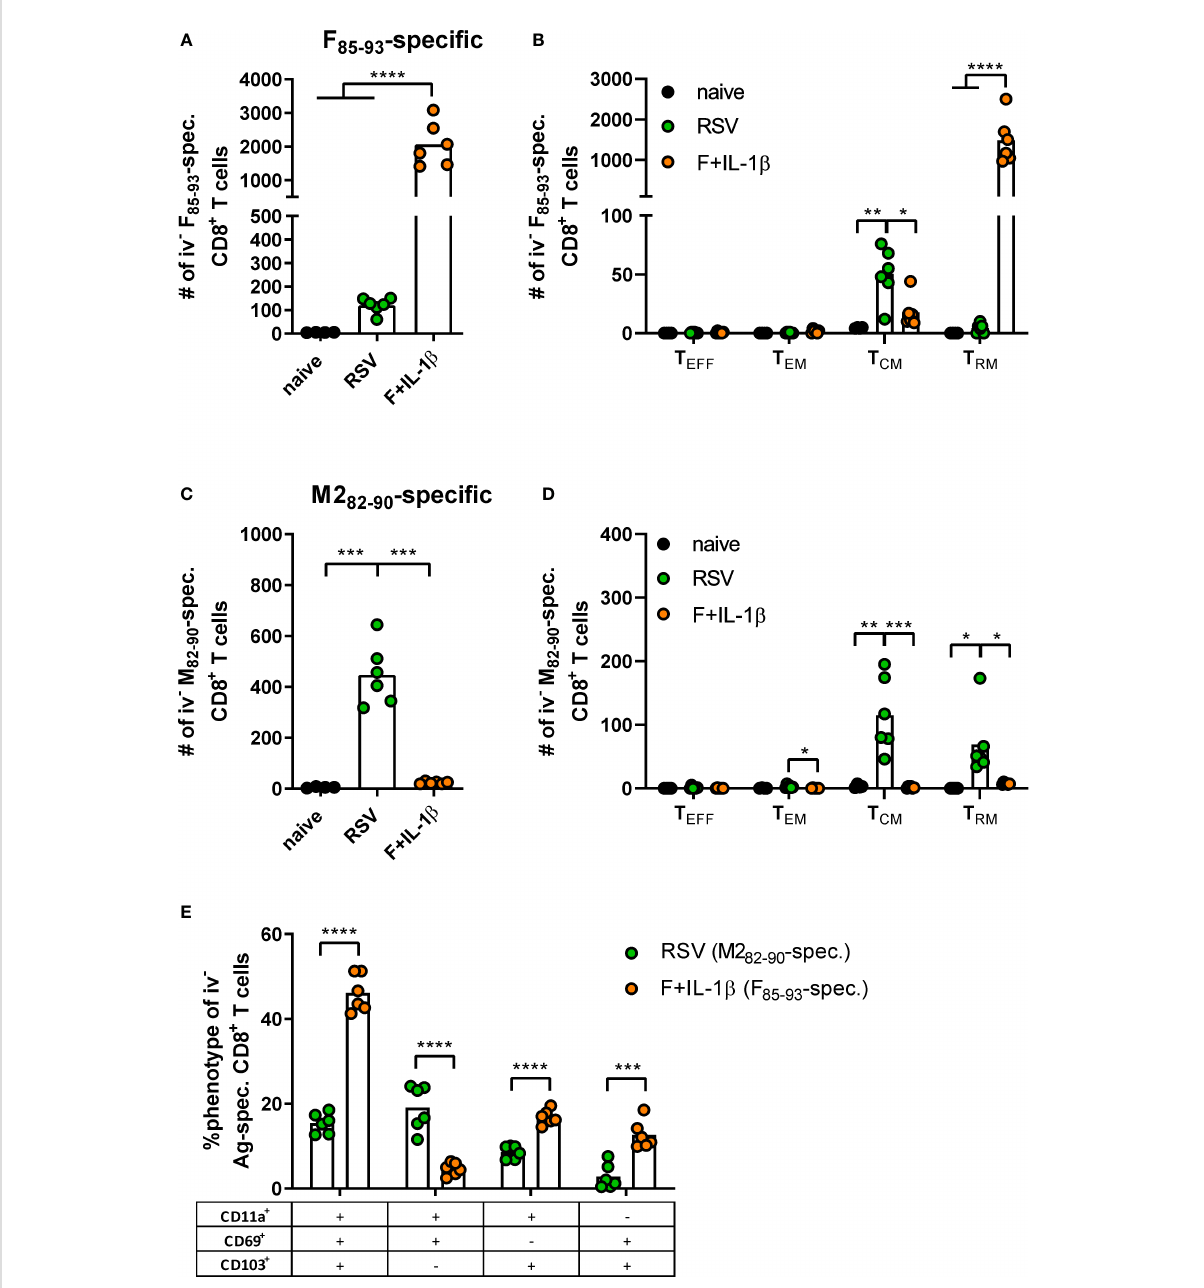
FIGURE 5 T cell phenotypes induced by mucosal vaccination and a primary RSV infection. BALB/cJRj mice were immunized or infected as described above and isolated lung lymphocytes were analyzed seven weeks later. Counts of F 85-93 pentamer + (A) and M2 82-90 pentamer + CD8 + T cells (C) per lung and of speci fi c memory T cell subsets (B, D) are shown; effector T cells, T EFF , KLRG1 + CD127 - ; effector memory T cells, T EM , KLRG1 + CD127 + ; central memory T cells, T CM , KLRG1 - CD69 - CD103 - CD127 + ; T RM , KLRG1 - CD127 +/- CD69 + CD103 + ; gating scheme in Supplementary Figure 2. (E) Pentamer + CD8 + T cells (M2 82-90 -spec. in RSV group, F 85-93 -spec. in Ad-F+Ad-IL-1 b group) that were not stained by the intravenous staining were further characterized for their expression of CD11a, CD69, and CD103. Bars represent group means overlaid with individual data points. n=4-6. Data were analyzed by one-way ANOVA followed by Tukey´s post test (A-D) or two-tailed Student ’ s t -test (E) . * p <0.05, ** p <0.005, *** p <0.0005, **** p